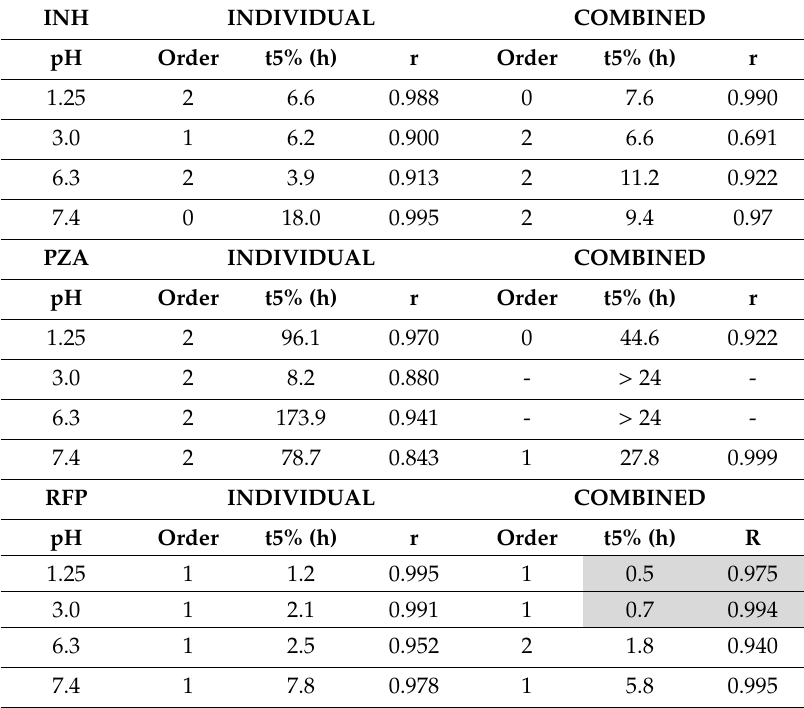
Table 3. Kinetic orders to calculate the shelf life at which 5% of the initial dose is degraded (t5%). r: